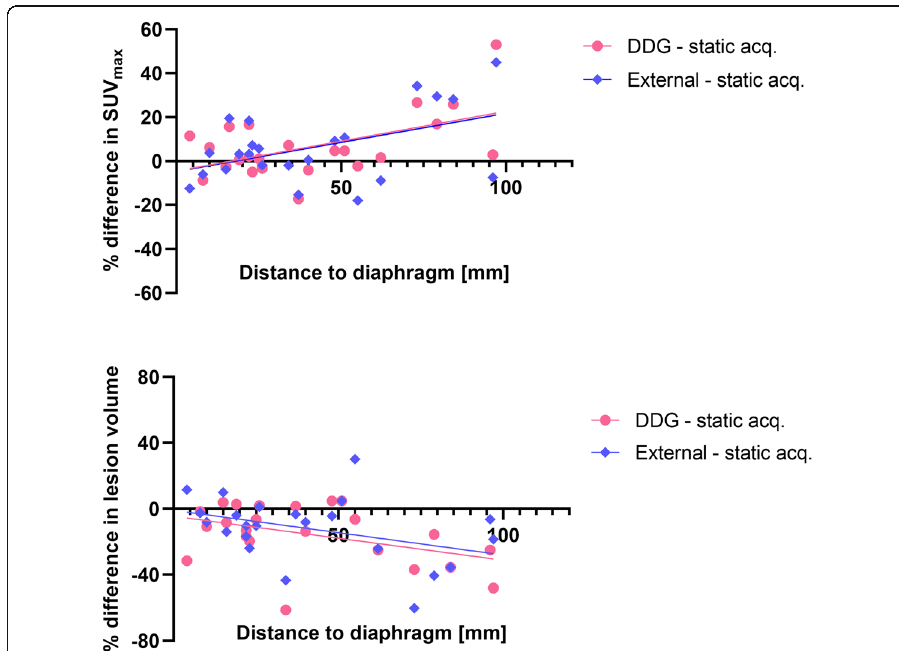
Fig. 5 Relation between a lesion ’ s distance to the diaphragm and the improvement in image quality (upper graph: difference in SUV max ; lower graph: difference in lesion volume). A week trend in the data can be seen, but the R 2 < 0.3 and is not